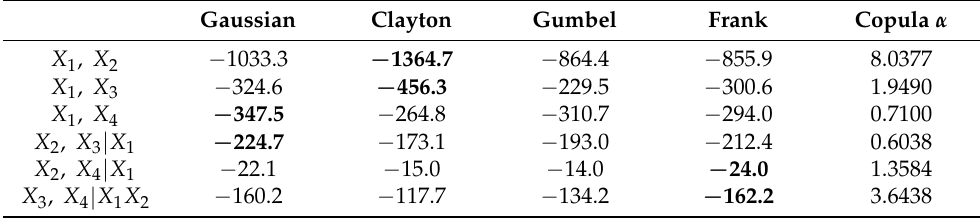
Table 5. Values of parameter estimation and AIC method ( N =